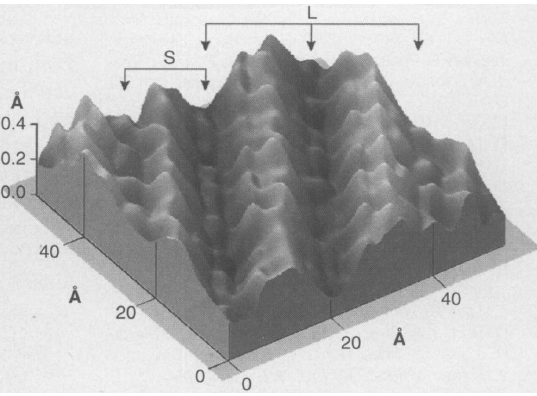
Figure 5: A 30-nm-thin Ag layer obtained using electroless techniques. Reproduced with permission from